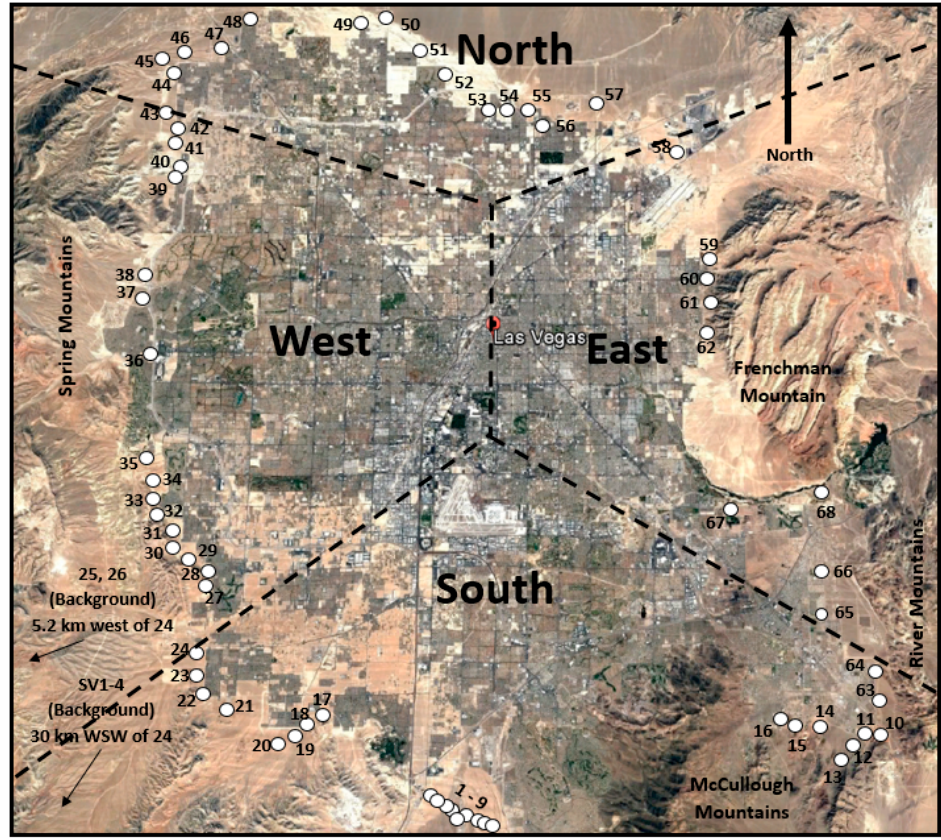
Figure 2. Sample locations and sectors across the Las Vegas Valley (Google maps).